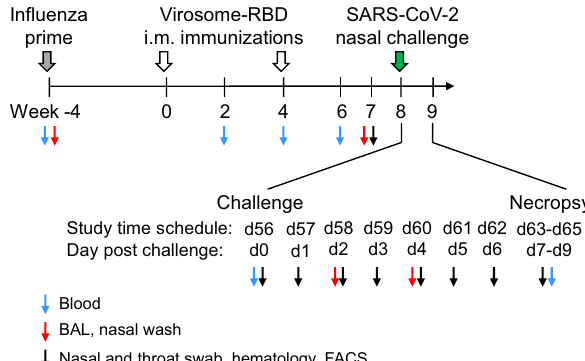
Figure 1. Immunization and challenge schedule in rhesus macaques. Four weeks before vaccination (week -4), Rhesus macaques of the virosome vaccine group (n = 6) and the control group (n = 4) were immunized intramuscularly (i.m.) with inactivated influenza virus particles (grey arrow) to prime immune responses against influenza specifically the hemagglutinin (HA). Subsequently, animals of the vaccine group were immunized at weeks 0 and 4 by the i.m. route with influenza-derived virosomes displaying the RBD derived from the SARS- CoV-2 Wuhan strain (open arrow). At week 8 (day 56: d56 of the study design), all animals were challenged (corresponding to d0) by the combined intranasal and intratracheal route with 1 × 10 5 TCID 50 of SARS-CoV-2 (green arrow). At different timepoints before and after challenge (d56 to d63-d65), diverse types of samples were collected, as indicated by color coded arrowheads. Animals were sacrificed either at day 7 (d63), 8 (d64) or 9 (d65) post-challenge.